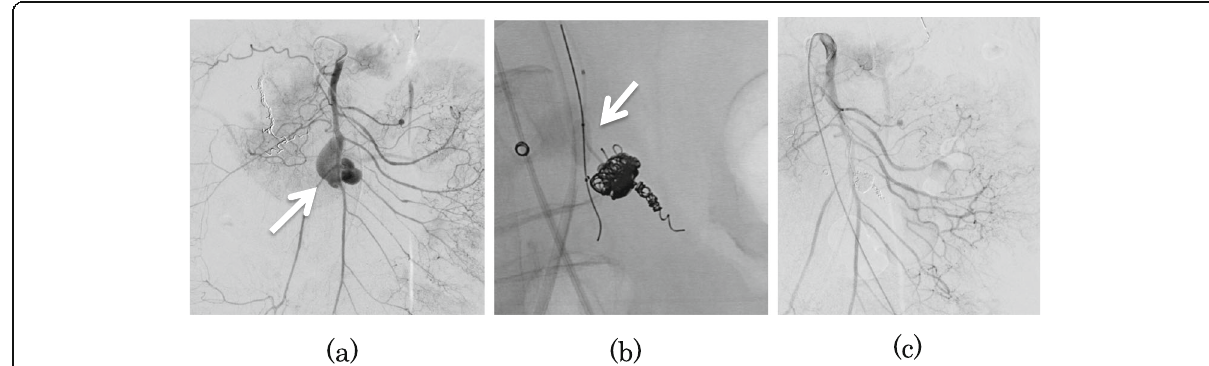
Fig. 3 Angiography revealed a jejunal aneurysm with massive extravasation ( a ). Embolization was performed using detachable coils in the distal side of the aneurysm. Subsequently, we embolized the aneurysm by filling the same coils. Finally, coils were deployed into the proximal side of the aneurysm during balloon occlusion of SMA to avoid coil migration ( b ). SMA angiogram after embolization, jejunal blood flow was well maintained ( c )